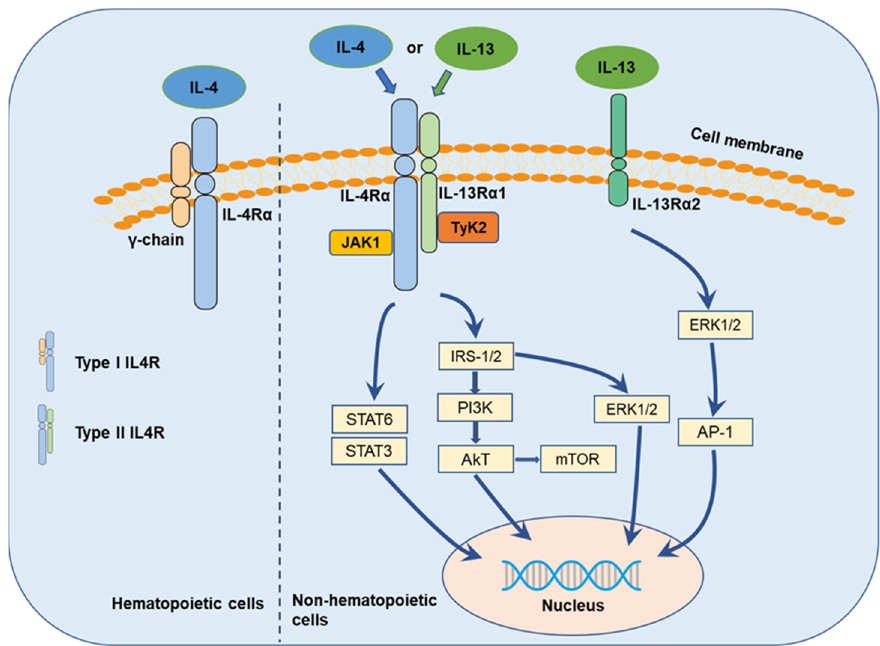
Figure 2. IL-4/IL-13 axis and their signaling